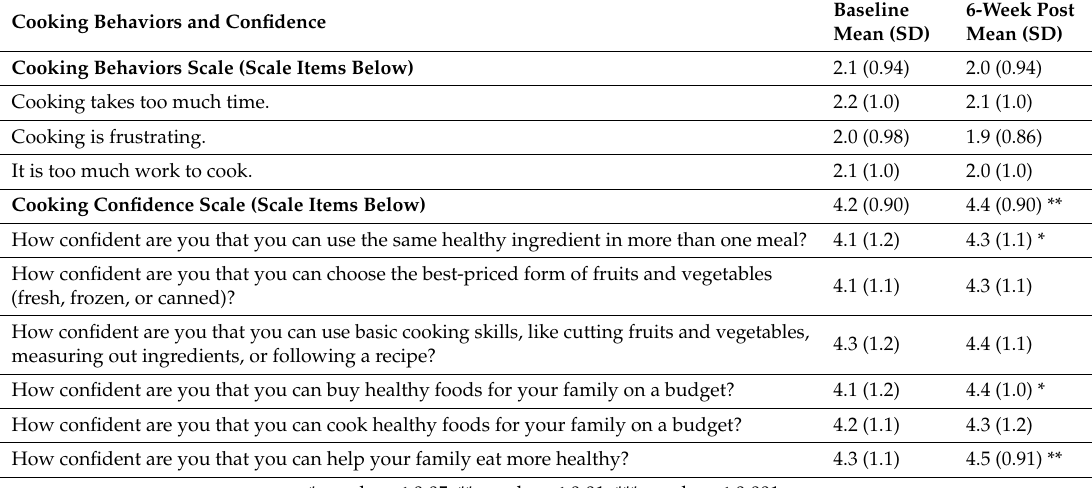
Table 4. Cooking Behaviors and Confidence Mean Changes.